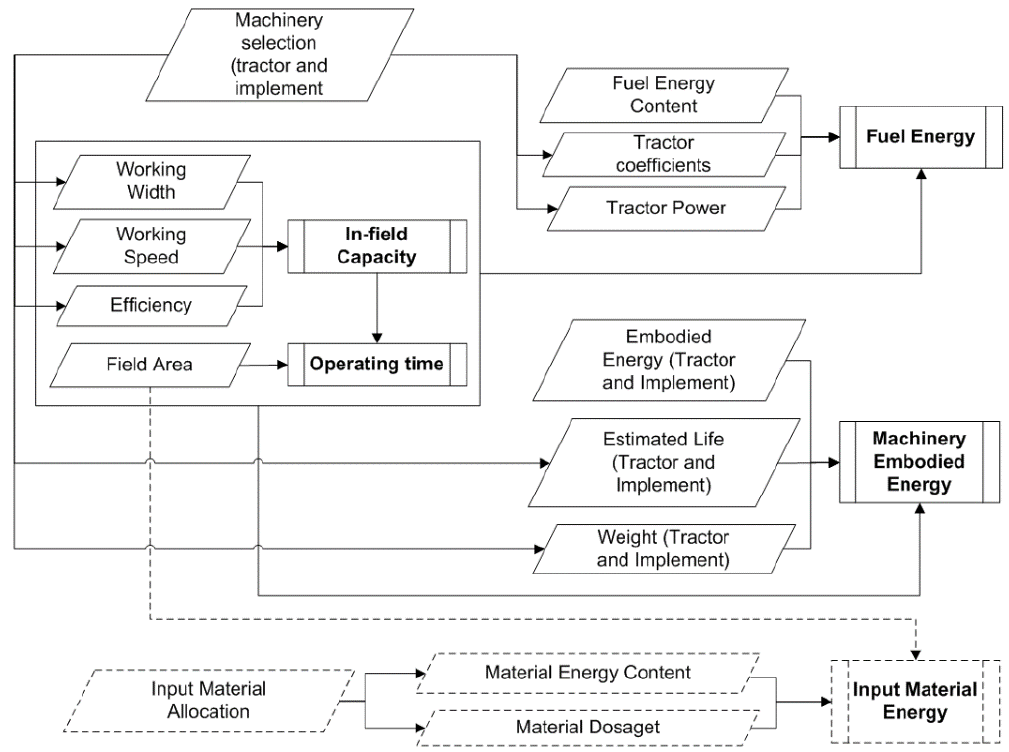
Figure 3. Estimation process of energy elements for the in-field part of an operation (the dotted lines correspond to input material flow (IMF) operations).